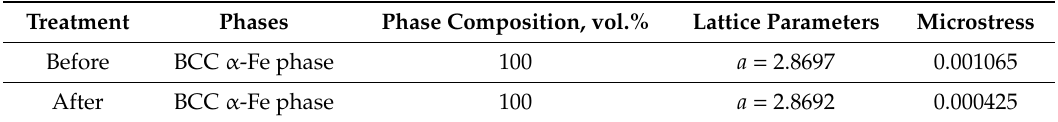
Table 3. XRD data.